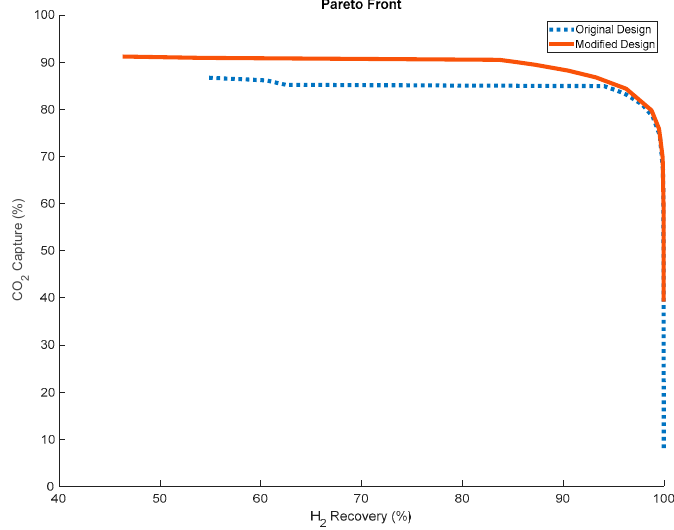
Figure 16. Comparison of the Pareto fronts for the original and modified designs.